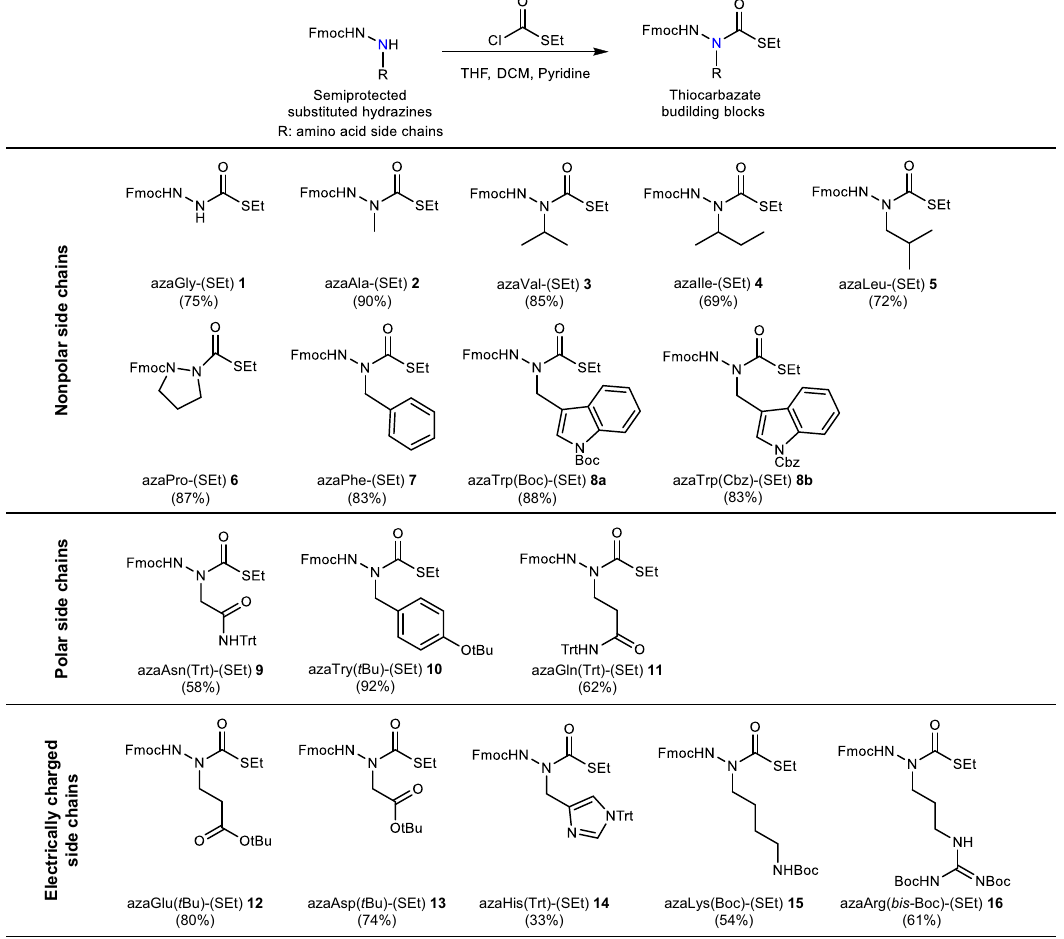
Fig.2|SynthesisofS-ethylthiocarbazateasbench-stableandlatentaza-amino acid surrogates with natural amino acid side chains. Sixteen Fluor- enylmethyloxycarbonyl (Fmoc)-protected thiocarbazate amino acid building